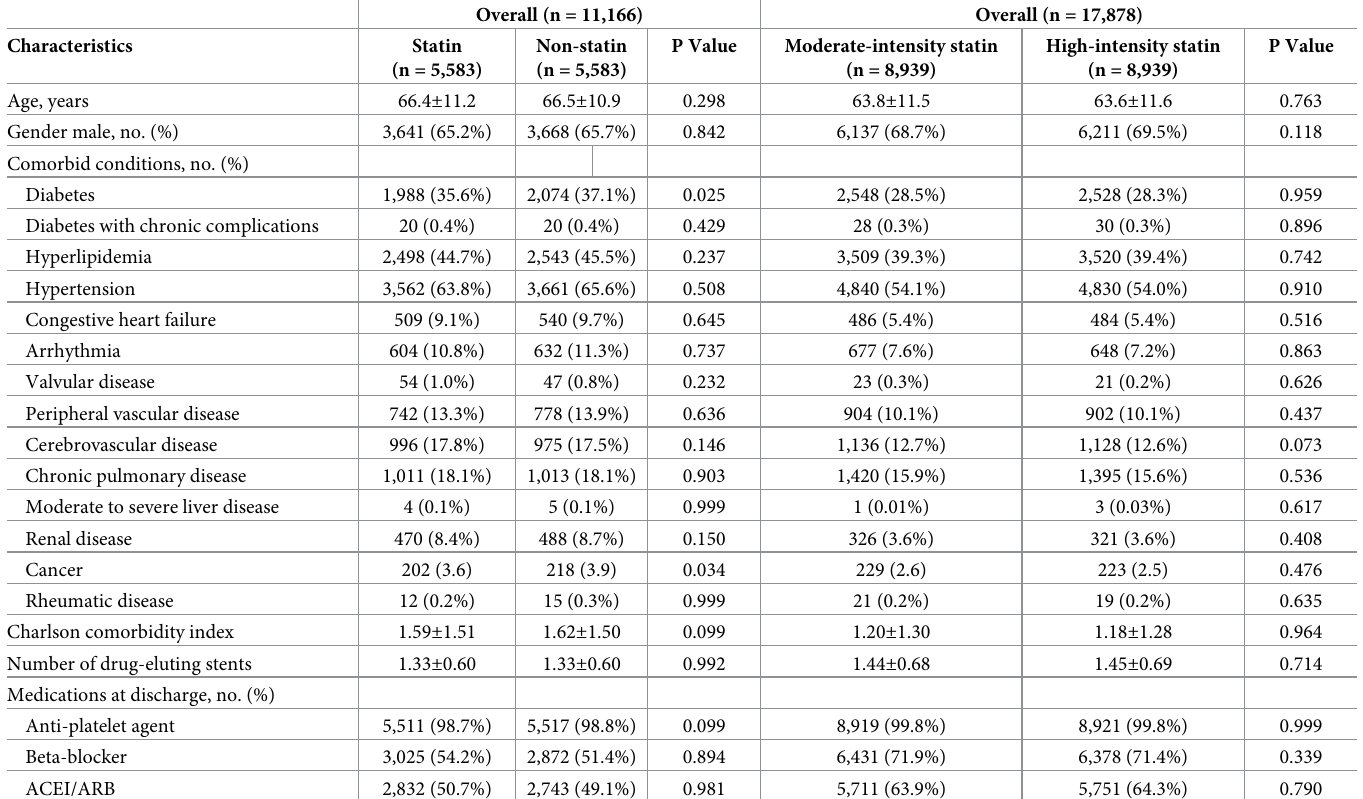
Table 2. Characteristics of propensity-score matched patients according to statin therapy.